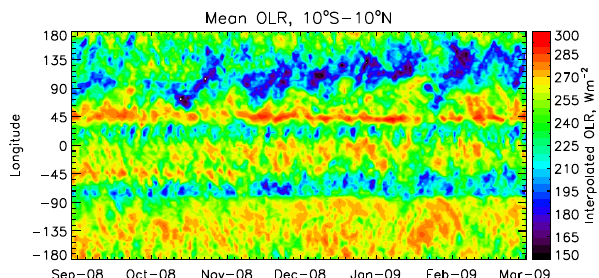
Fig. 9. Daily mean interpolated OLR averaged over 10 ◦ S–10 ◦ N latitudes during September 2008 to February 2009. Observe the low OLR at longitudes 60–180 ◦